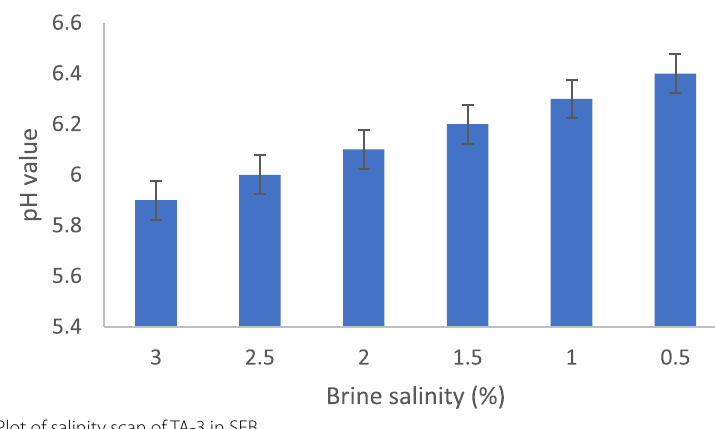
Fig. 9 Plot of salinity scan of TA-3 in